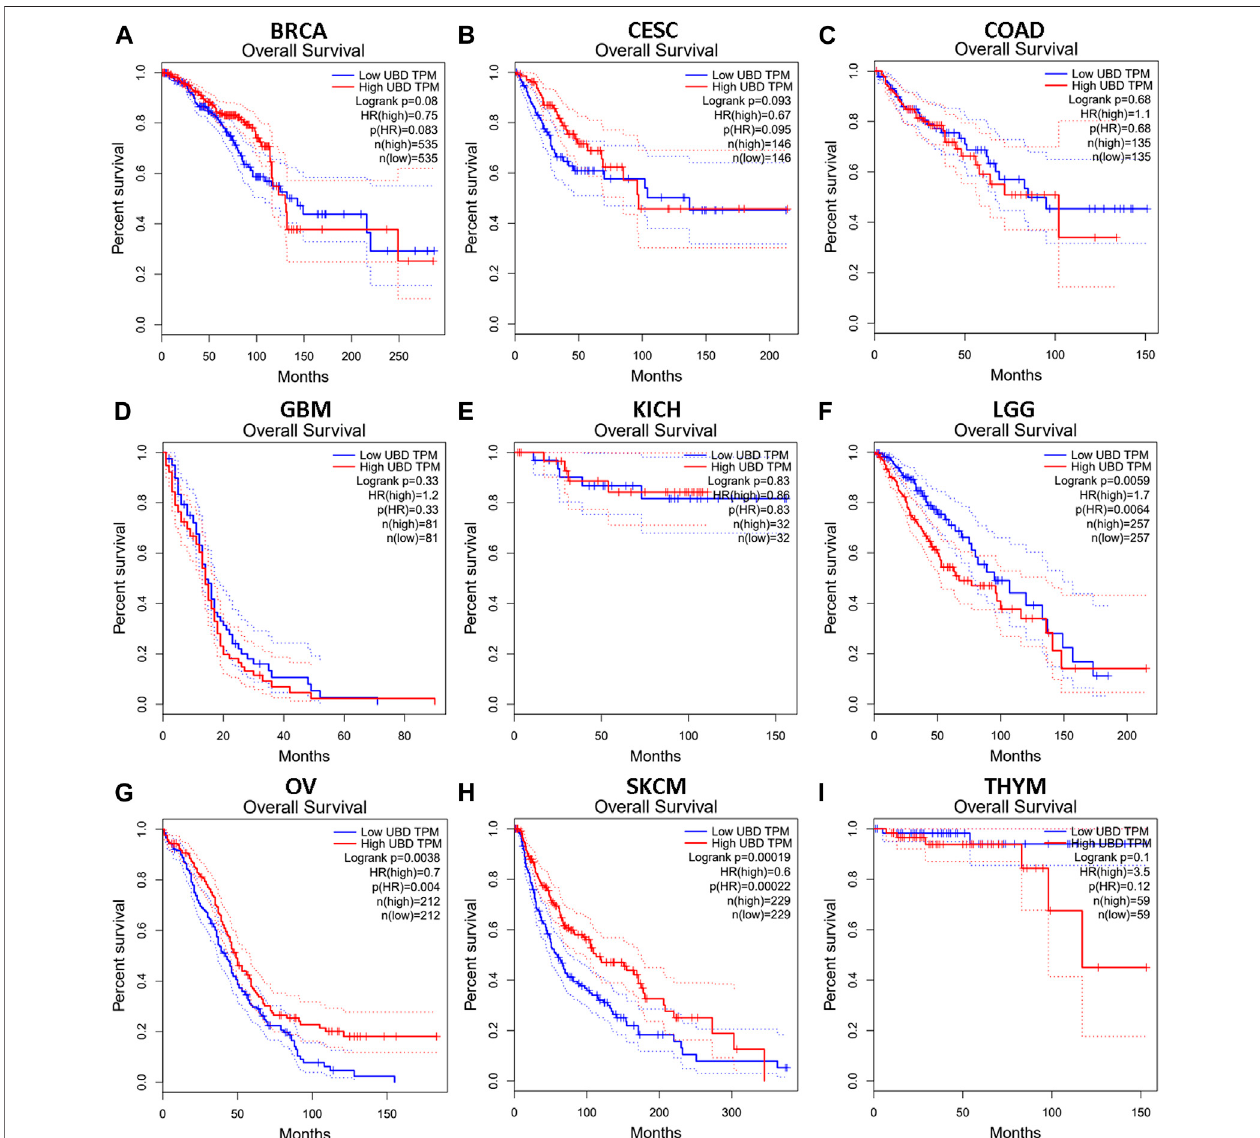
FIGURE 2 | The OS analysis for FAT10 in various human cancers via GEPIA database. (A – I) The OS plot of FAT10 in BRCA (A) , CESC (B) , COAD (C) , GBM (D) , KICH (E) , LGG (F) , OV (G) , SKCM (H) , THYM (I) .